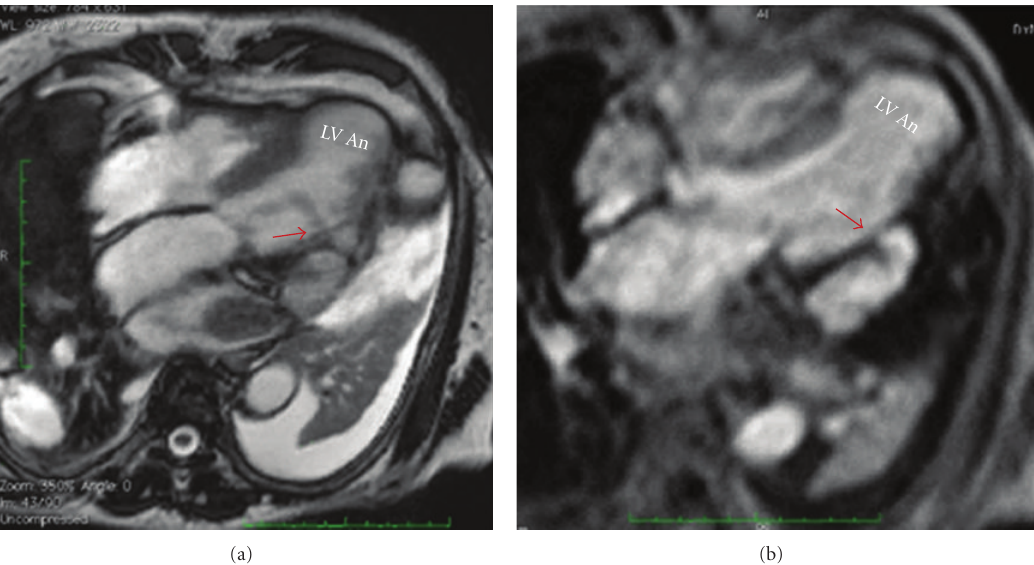
Figure 5: (a) Four-chamber view cardiac MR cine SSFP shows an apical aneurysm (LV An) and a lateral left ventricular pseudoaneurysm (red arrows). Apical transmural hyperenhancement is also seen in